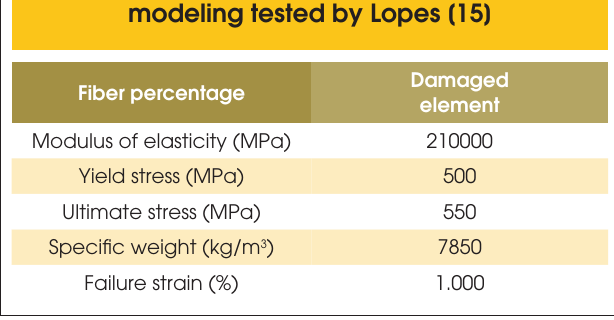
Table 11 – Steel data used in the